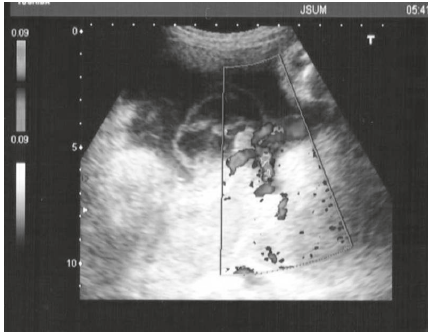
Figure 1: Macroscopic view of the placenta in Case 4 at delivery, showing an oval-shaped structure wrapped in the amniotic mem- brane.